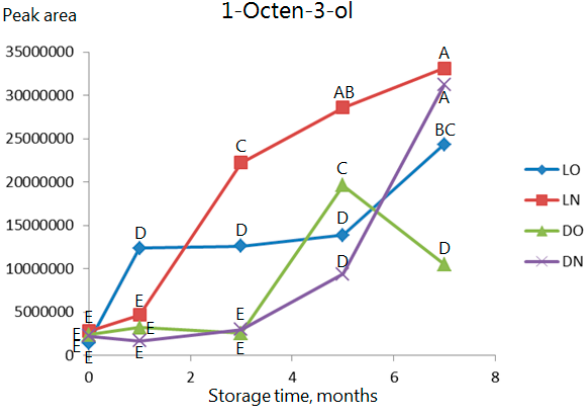
Figure 6. As Figure 3 but data for 1-octen-3-ol. Observations marked with the same letter are not significantly different ( p > 0.05).